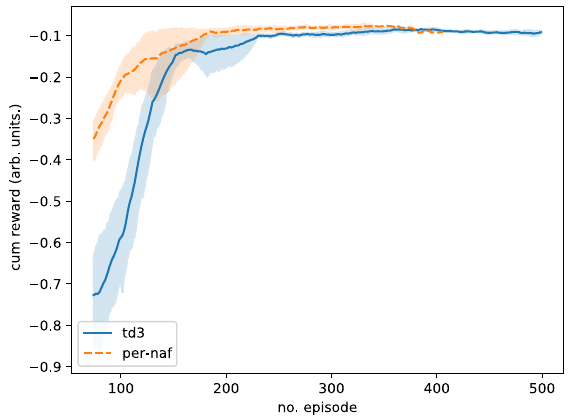
FIG. 16. A comparison between the state-of-the-art TD3 algorithm and PER-NAF on the AWAKE simulated environment. The overall performance is